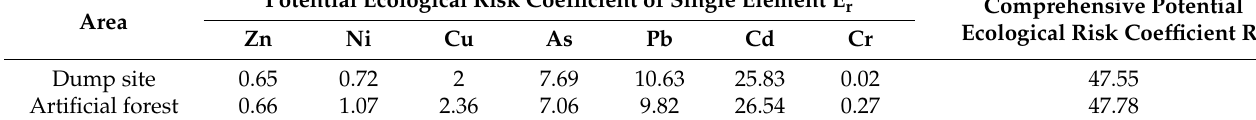
Figure 3. Distribution diagram of ground accumulation index.